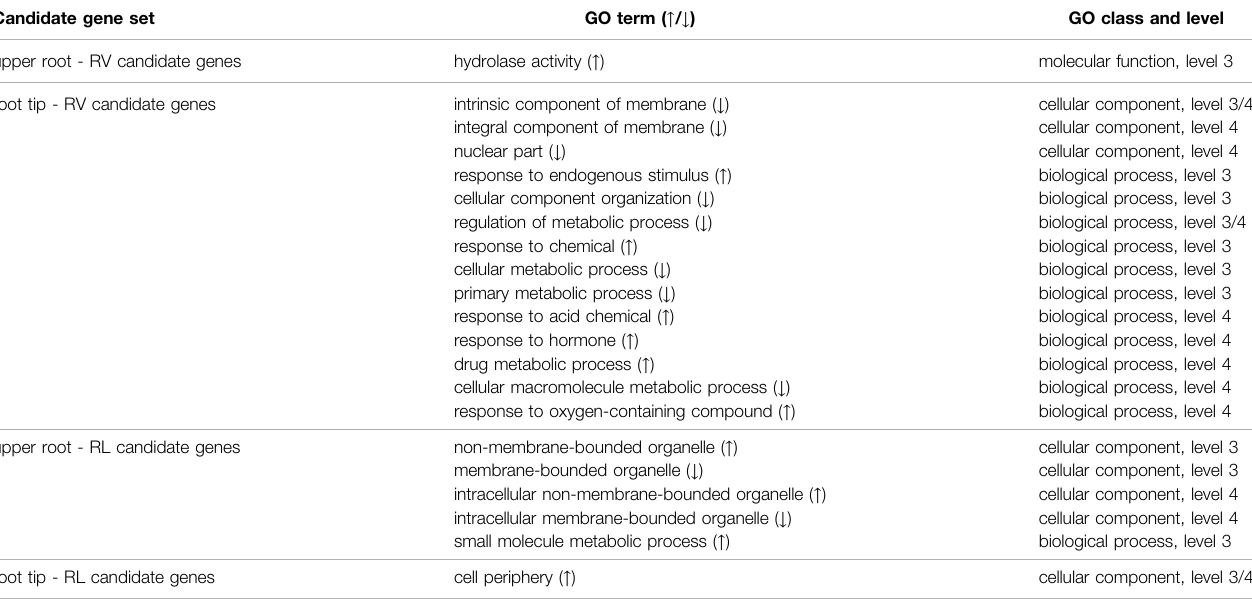
TABLE 2 | Summary of the GO enrichment analysis at deeper GO levels. Candidate gene